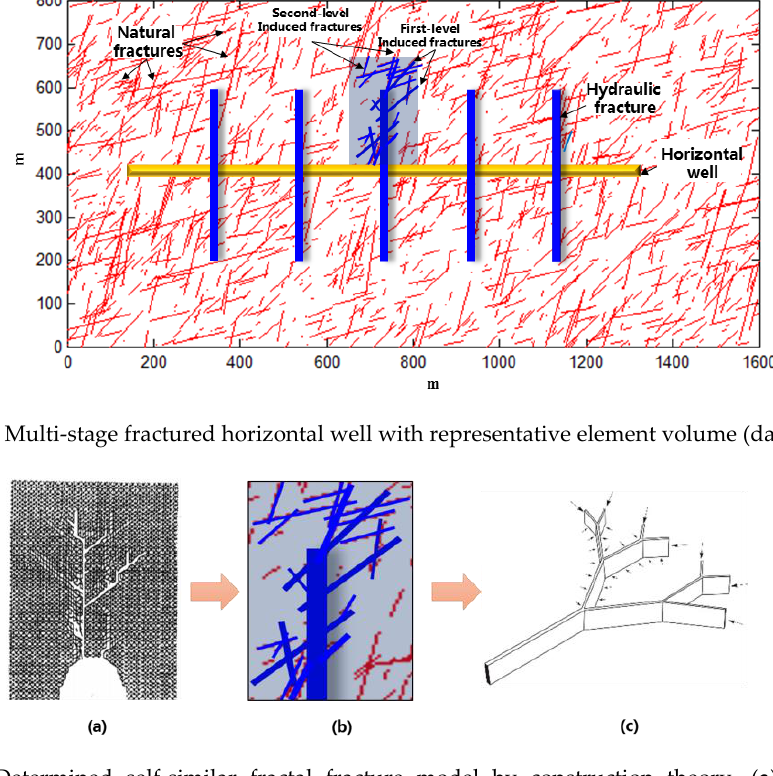
Figure 4. Determined self-similar fractal fracture model by construction theory. ( a ) represent branching fracture propagation geometry, modified from [23]; ( b ) represent the fracture representative element volume in Figure 2; ( c ) is determined Y-shape self-similar fractal fractures